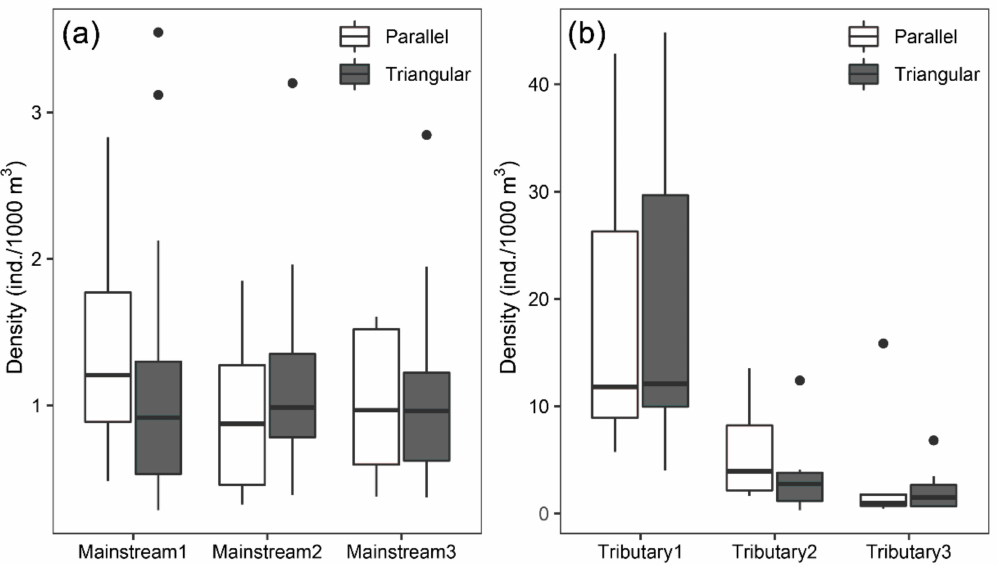
Figure 2. Box–Whisker plots of fish densities estimated under the two type of survey designs in ( a ) the mainstream survey units and ( b ) the tributary survey units. The central box covers 50% of data values, the vertical line represents the range, and the horizontal line indicates the median. The points above the whiskers represent